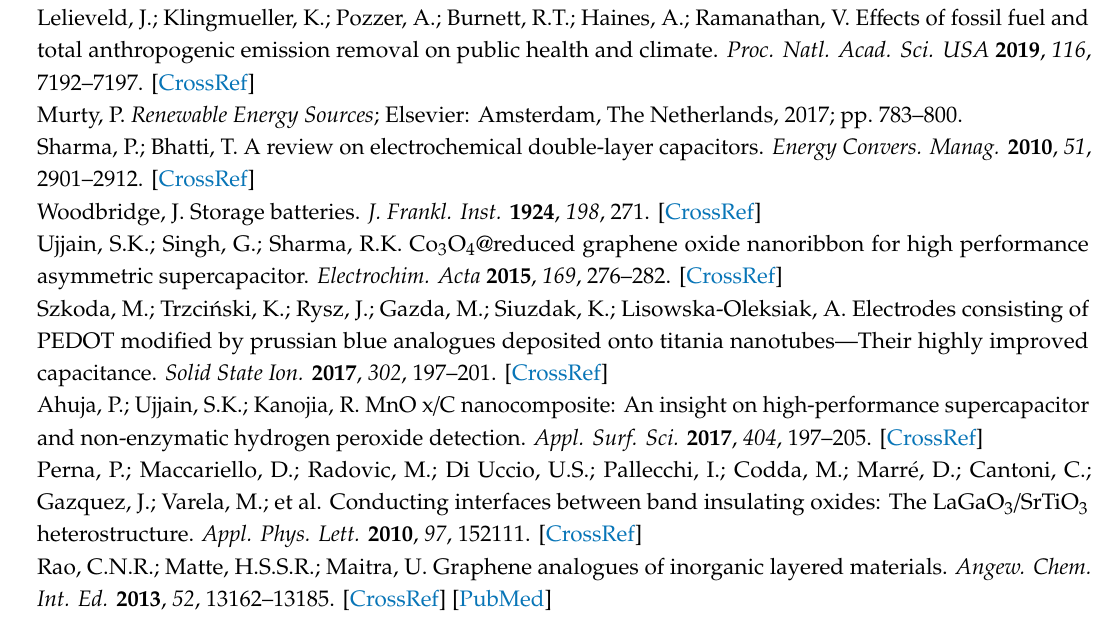
Figure S1: SEM on higher magnification for hydrated WO 3 − x , Figure S2: (a) CV curves of hydrated WO 3 − x electrode in 0.2 M K 2 SO 4 . Scan rates 5–500 mV s − 1 . Dependence of anodic current at 0.5 V (b) vs. scan rate and (c) vs. square root of the scan rate, Figure S3: The equivalent circuits used for modeling. Figure S4: The impedance spectra, experimental and fitted, of bulk WO 3 and hydrated WO 3 − x recorded at 0 V and 0.6 V vs. Ag / AgCl (3 M KCl), Table S1: The results of fitting procedure, Table S2: Comparison of the electrochemical properties of the non-crystalline WO 3 with some previous reports on metal oxide-based